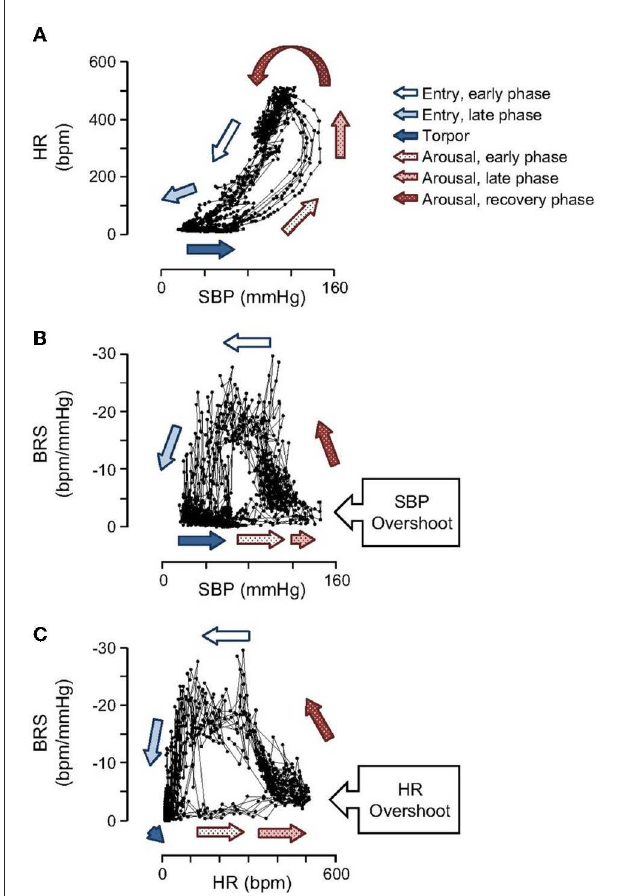
FIGURE3 Open loops in hysteresis plots shown for SBP, HR and baroreceptor sensitivity (BRS) illustrate that cardiovascular control operates in fundamentally different ways during entrance and arousal. Importantly, the hysteresis between HR and SBP (A) illustrates that BP increases prior to HR during arousal and declines at the same rate as HR during entrance. During arousal, SBP (B) and HR (C) both increase to near maximal levels before BRS begins to increase [Horwitz et al.